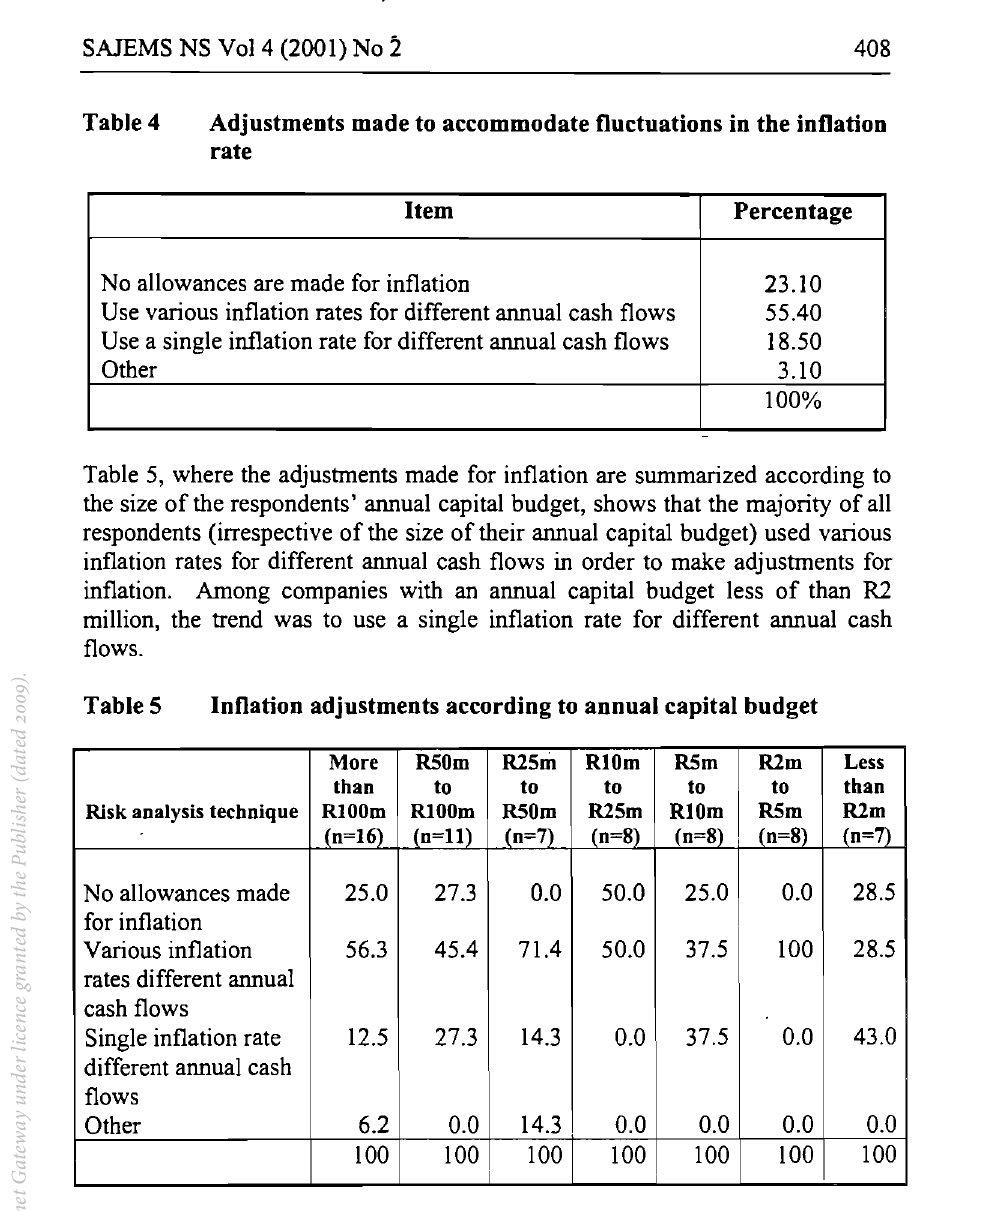
No allowances made for inflation Various inflation